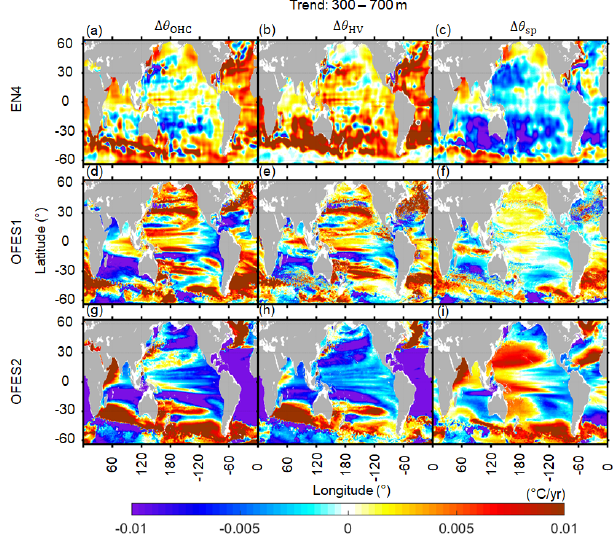
Figure 15. As for Fig. 14 but for the middle layer